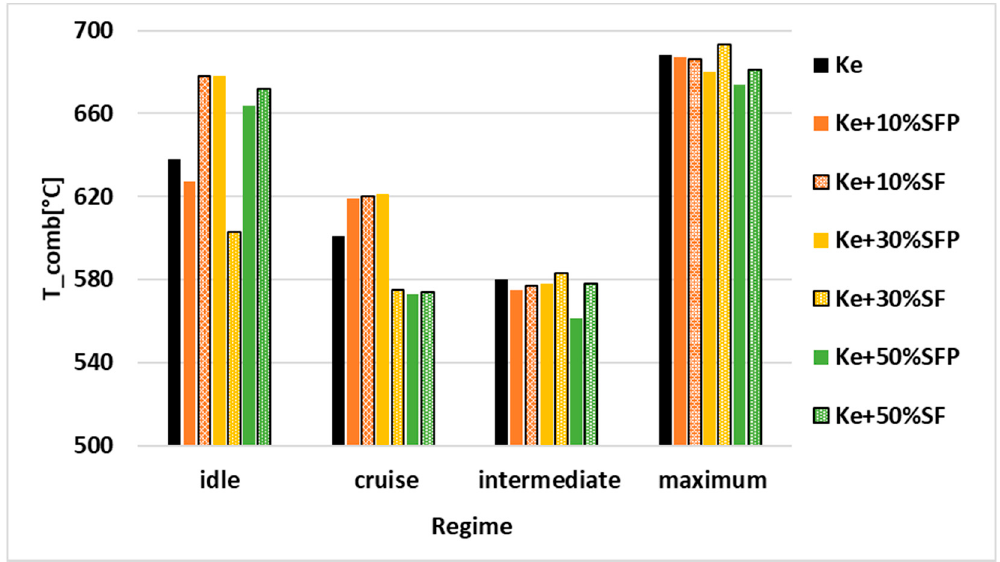
Figure 6. Variation of (T_comb) (°C) depending on regime and blends.